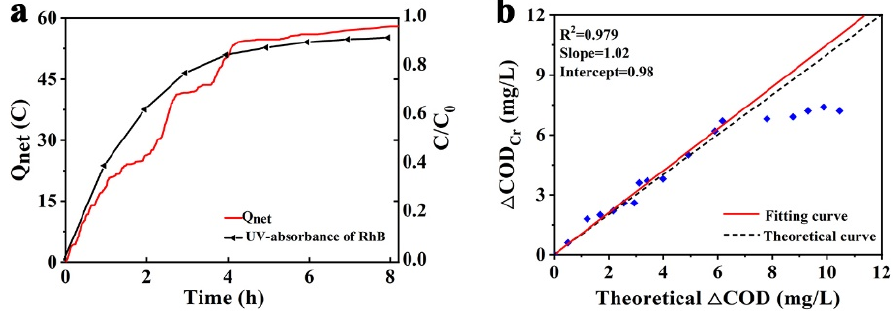
Figure 8. ( a ) Net charge transferred and UV-Vis absorbance of RhB with irradiation of PFC; ( b ) the Correlations between TECOD with actual COD.